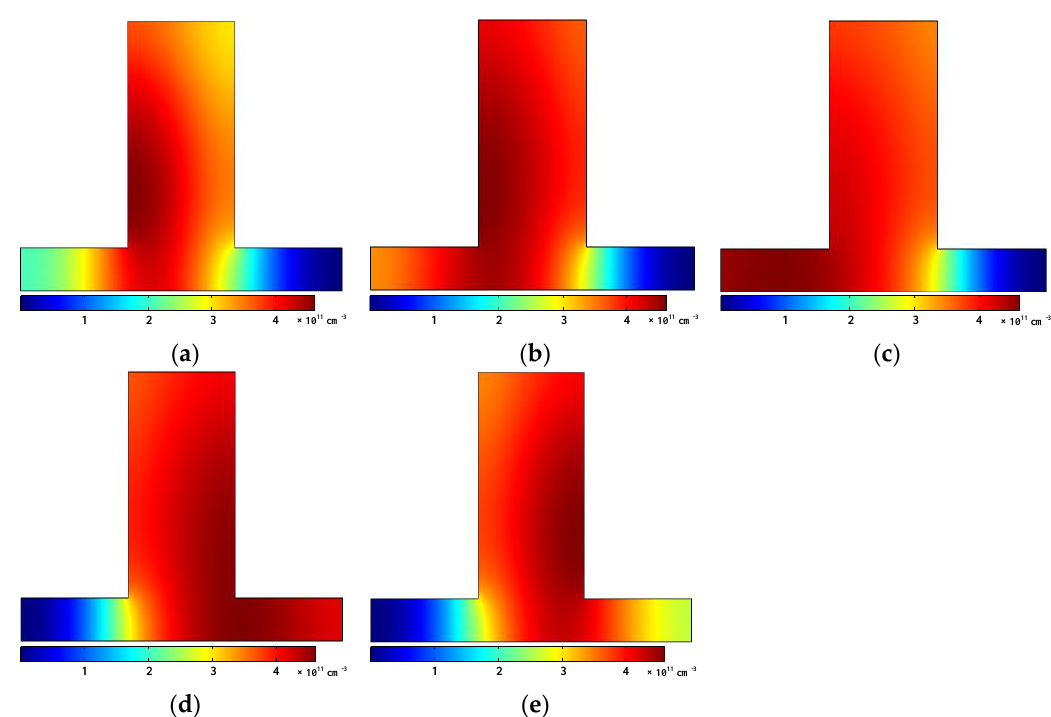
Figure 14. Spatial distribution of the CO density for times ( a ) 2 ms, ( b ) 6 ms, ( c ) 10 ms, ( d ) 14 ms, and ( e ) 18 ms for the reactor at 22 kV AC voltage and 1 cm distance between electrodes.